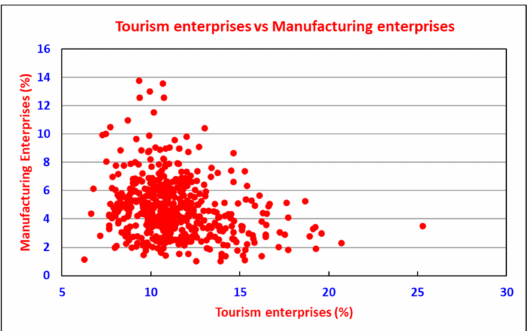
Figure 9. The linear relationship between manufacturing and tourism enterprises in United States micropolitans.